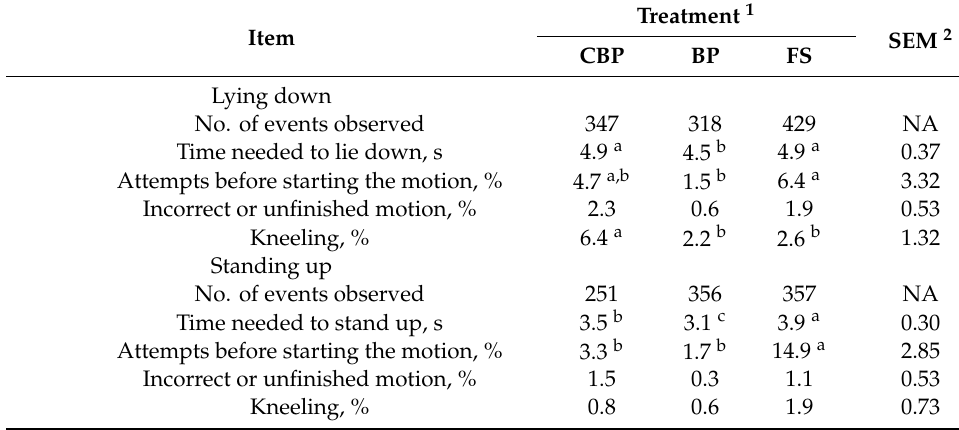
Table 6. E ff ects of the treatments (compost bedded pack barn, bedded pack barn and freestalls) on each behavioral variable measured during the motion of lying down / standing